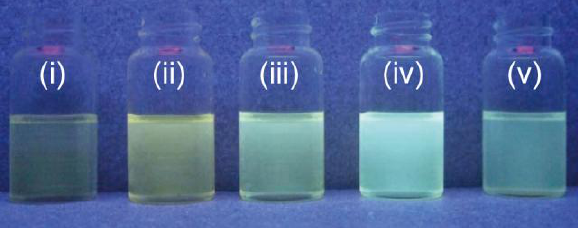
Figure 5. Digital photograph of an NMP solution of Poly(3,4-BAHBA- co -4HCA)s under 365 nm UV light excitation. ( i ) 100/0, ( ii ) 75/25, ( iii ) 50/50, ( iv ) 25/75, ( v ) 0/100 in molar ratios.